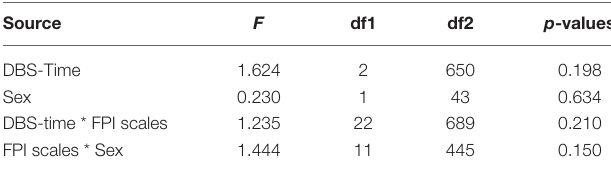
TABLE 2 | Fixed effects of the generalized linear mixed model for the 12 scales of the